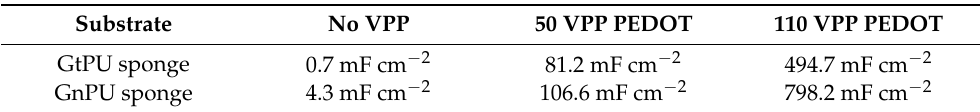
Figure 6. Charge-discharge ( CD ) testing curves of symmetric supercapacitor cells assembled with GtPU, 50 PEDOT/GtPU and 110 PEDOT/GtPU sponge ( a ), GnPU, 50 PEDOT/GnPU and 110 PEDOT/GnPU sponge ( b ). CD curves were all obtained with the current density of 0.1 mA cm − 2 . Table 1. Specific capacitance values of GtPU, 50 PEDOT/GtPU, 110 PEDOT/GtPU, GnPU, 50 PEDOT/GnPU and 110 PEDOT/GnPU sponge. The calculation was based on CD curves ob- tained with the current density of 0.1 mA cm − 2